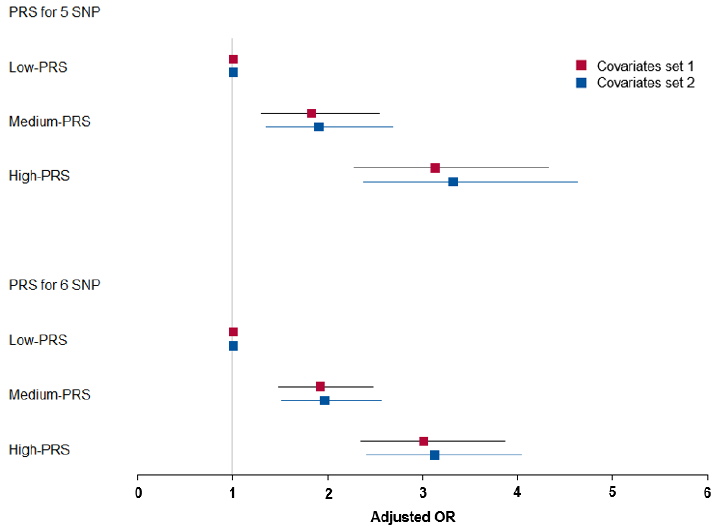
Figure 3. Adjusted odds ratio (ORs) and 95% confidence intervals (CI) of 3-SNP PRS and 6-SNP PRS for duodenal ulcer risk. PRS was generated with the sum of the number of risk alleles in each genetic variant and classified into Low-PRS (0–3), Middle-PRS (4–5), and High-PRS ( ≥ 6) in the five-SNP model, respectively. SNP: Single nucleotide polymorphism; PRS: Polygenic risk score.